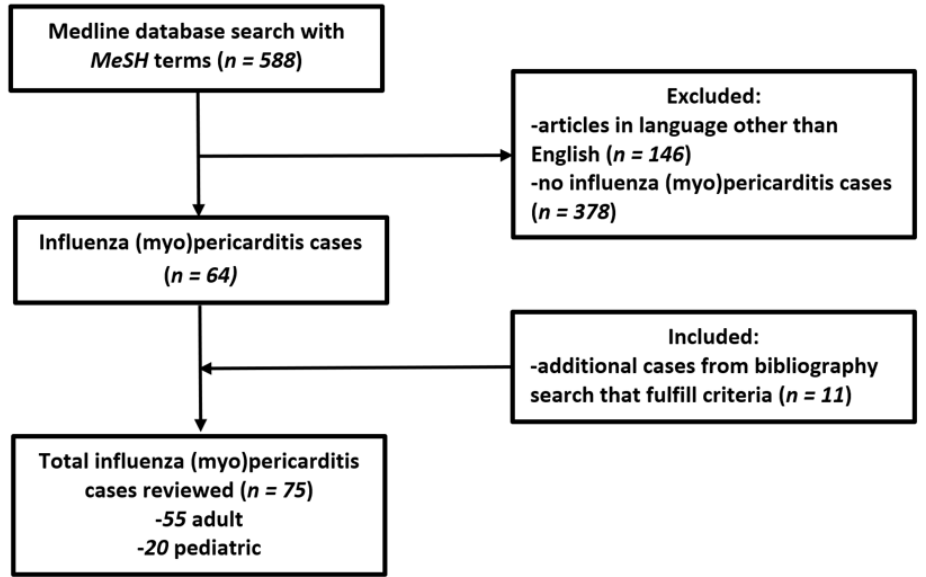
Figure 1. Flow chart of methodology and literature selection according to the PRISMA guidelines.